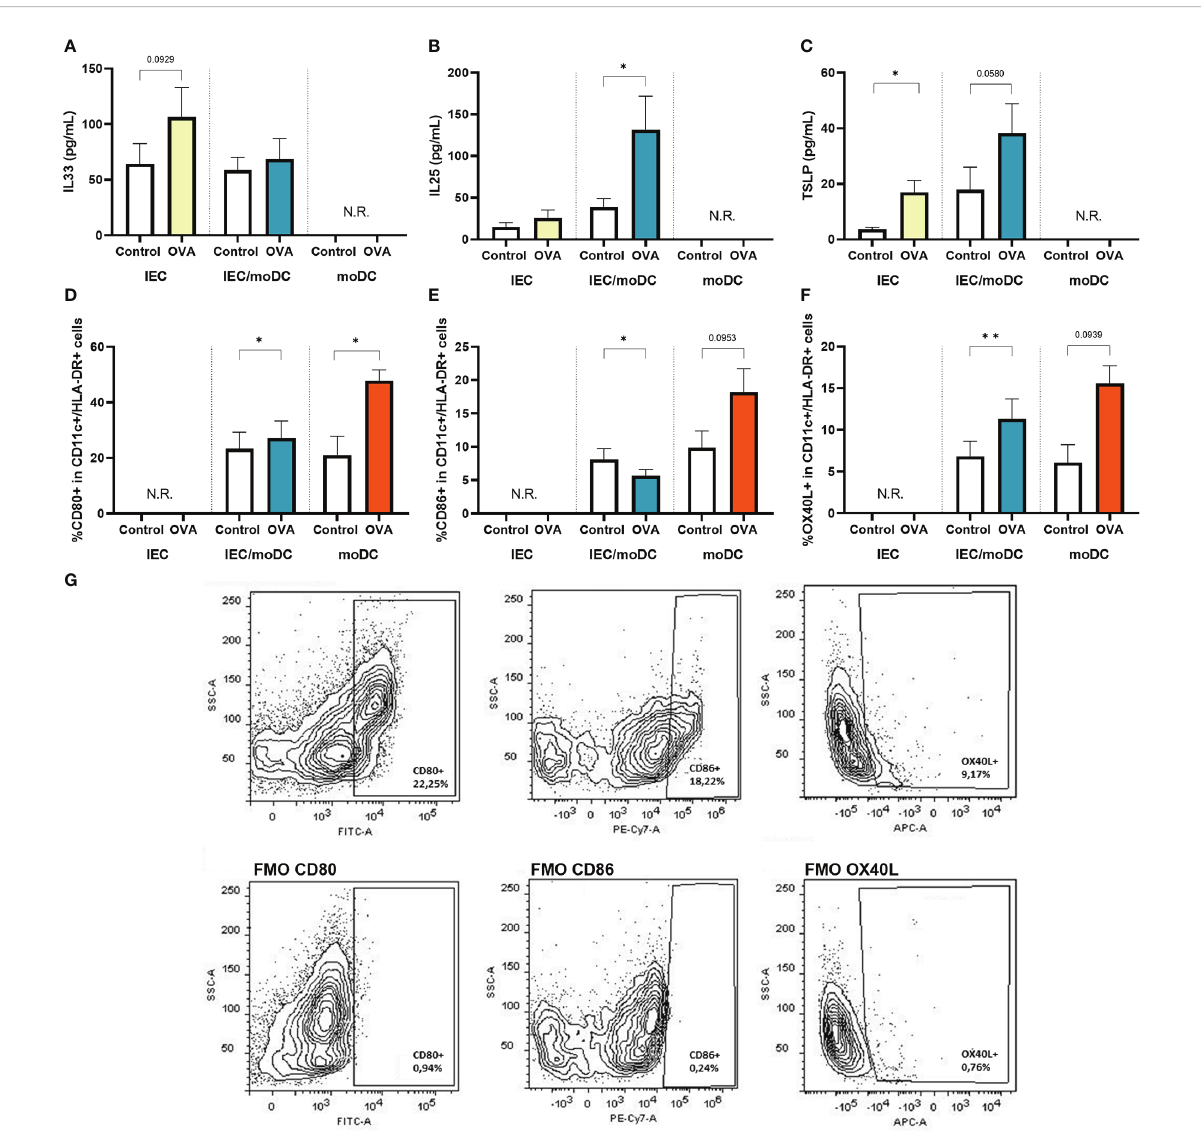
FIGURE 2 After 48h OVA exposure of IEC, IEC-moDC or moDC, secretion of epithelial derived alarmins (A) IL33, (B) IL25, and (C) TSLP was determined. In addition, the percentage of (D) CD80+, (E) CD86+ and (F) OX40L+ expressing moDCs (de fi ned as CD11c+ and HLA-DR+) was measured. A representative sample and corresponding FMO controls are shown in (G) . Data is analyzed by paired t-test, n=3, mean ± SEM (* p<0.05, **